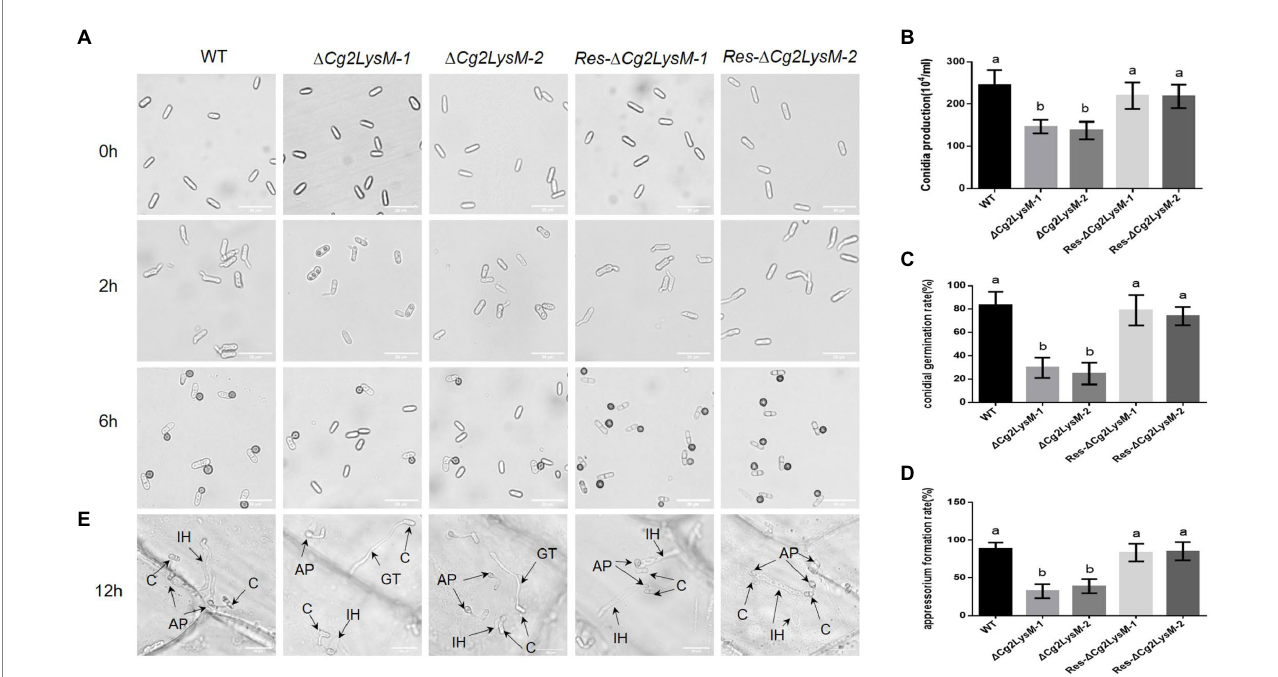
FIGURE 3 Conidial germination and appressorium formation assay of WT, Δ Cg2LysM and Res- Δ Cg2LysM . (A) Appressorium development progress of WT, ∆ Cg2LysM , Res- ∆ Cg2LysM . (B) Conidia production of WT, ∆ Cg2LysM , Res- ∆ Cg2LysM in CM media. Ten microscope fields were surveyed for every sample. (C) Conidia germination rates of WT, ∆ Cg2LysM , and Res- ∆ Cg2LysM at 2 h time intervals. (D) Appressorium formation rates of WT, ∆ Cg2LysM , Res- ∆ Cg2LysM at 6 h time intervals. (E) Invasion observation in onion epidermal cells. Equal volumes (5 μ l) of conidial suspensions (2.5 × 10 5 conidia/ml) from WT, ∆ Cg2LysM , Res- ∆ Cg2LysM were inoculated on the onion epidermal cells at 12 h time intervals. C, AP, IH, GT indicates the conidia, appressorium, infection hyphae and germ tube, separately. Data are shown as the means ± SD from three independent experiments. Different letters above columns indicate a significant difference ( p < 0.05). Bars = 20 μ